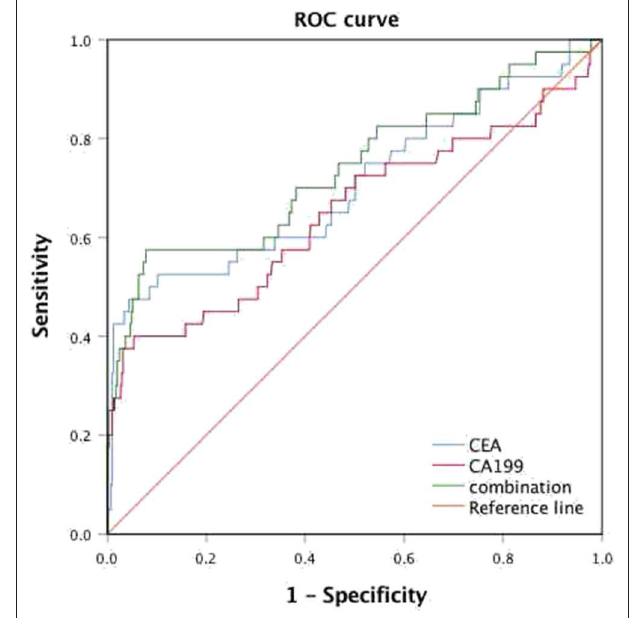
FIGURE 4 | Receiver operating characteristic (ROC) analysis for the prediction of synchronous liver metastasis in colorectal cancer patients. TABLE 3 | Comparison of synCRLM between different levels of FIB-4, APRI, NFS, and BRAD score. Group With Without synCRLM